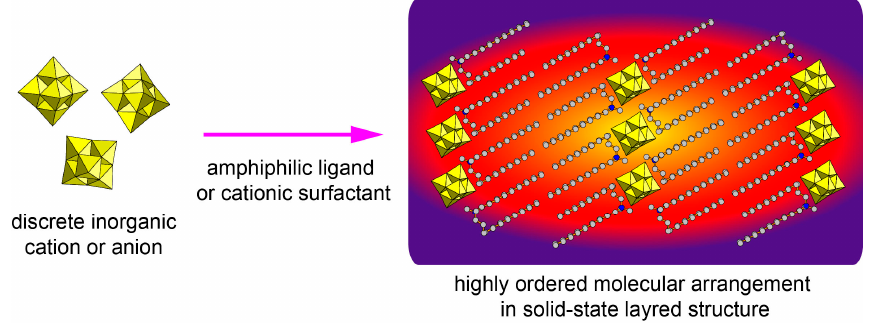
Figure 1. Schematic representation of hybrid surfactant single crystals with layered structures.